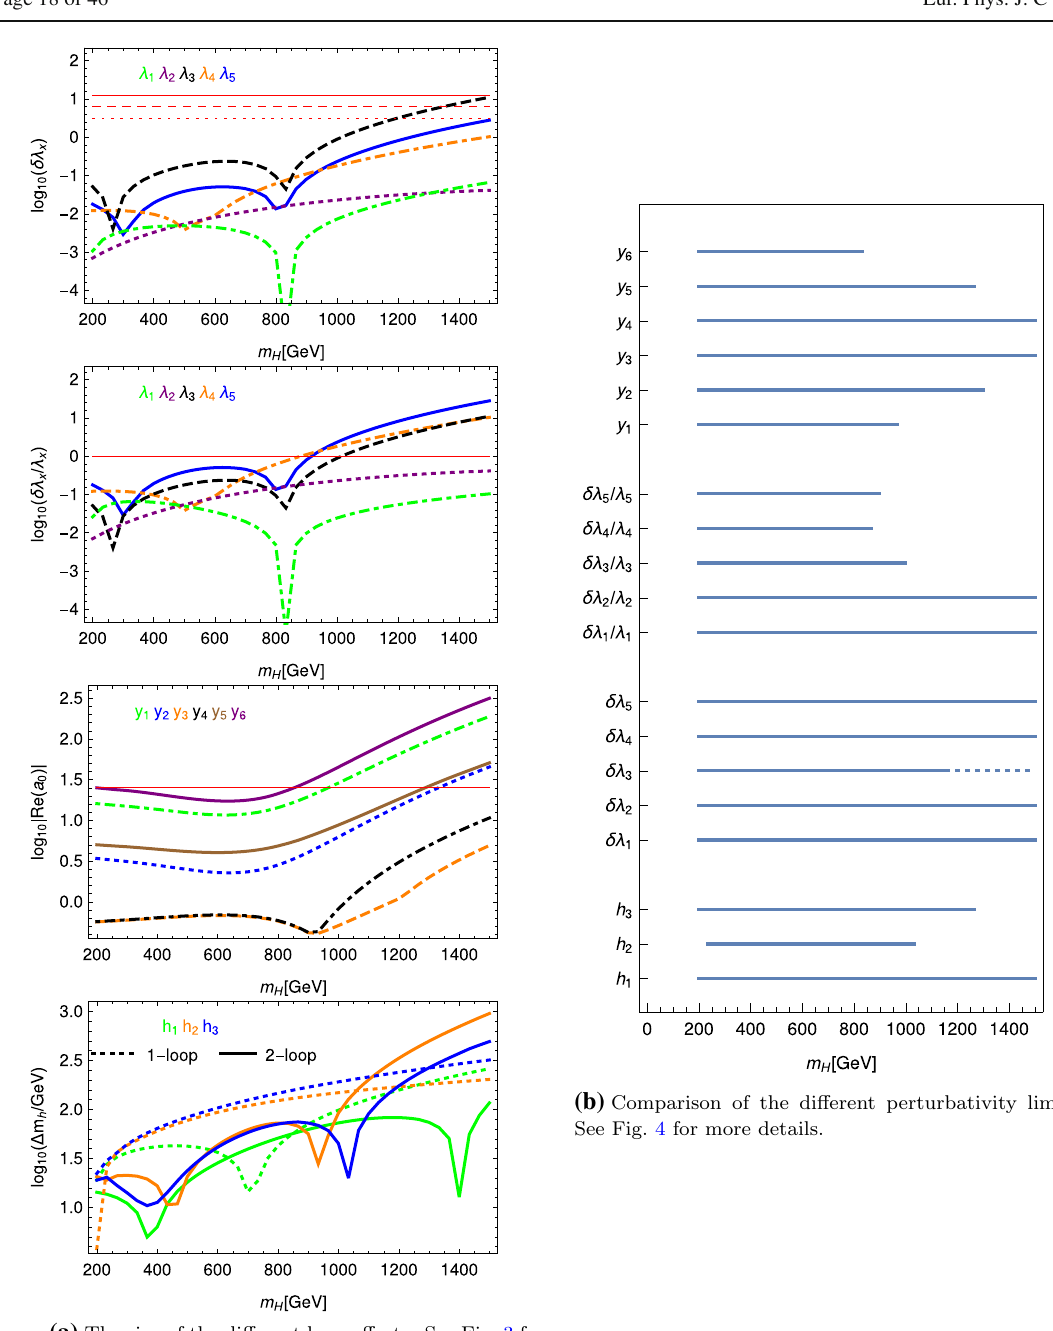
( a ) The size of the different loop effects. See Fig. 3 for more details. Fig. 6 Perturbativity limits as a function of m H . The other parameters are chosen as λ 2 = 0 . 1, λ 3 = 1, λ 4 = − 0 . 1, λ 5 = 0 . 1, α = 20 ◦ , s H = 0 .